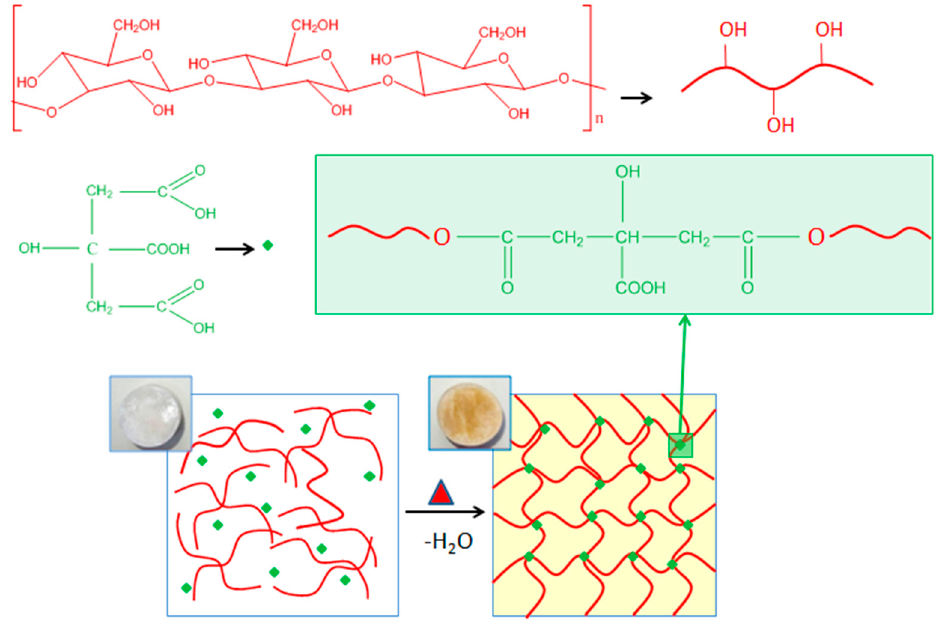
Figure 1. Illustration of the green crosslinking mechanism between salecan biopolymer and citric acid with the resulted citrate-salecan crosslinked networks.